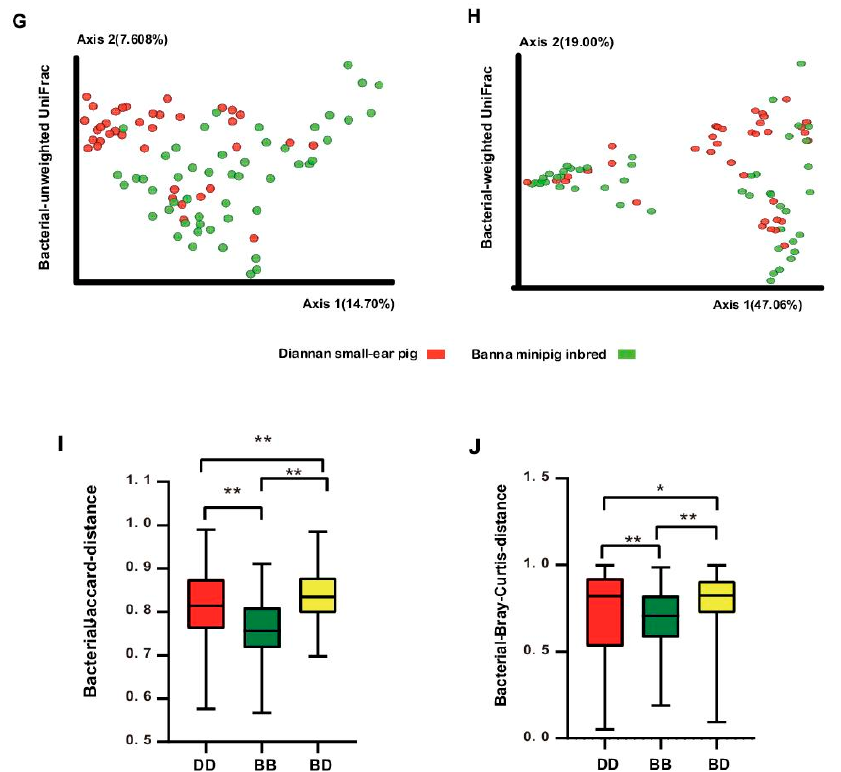
Figure 3. Comparison of alpha and beta diversity of the gut microbiota of Diannan small-ear pig and Banna minipig inbred. Four metrics were used for comparison including the number of observed OTUs ( A ), Shannon index ( B ), evenness index ( C ), and Faith index ( D ) in Diannan small-ear pig and Banna minipig inbred. Red and green bars represent the Diannan small-ear pig and Banna minipig inbred, respectively. ** p < 0.01, Mann–Whitney U-test. Jackknifed beta diversity analysis (Figure 3E–J) of gut microbiota for Diannan small-ear pig and Banna minipig inbred. ( E ): PCoA of bacterial Bray–Curtis. ( F ): PCoA of bacterial Jaccard. ( G ): PCoA of bacterial unweighted UniFrac. ( H ): PCoA of bacterial weighted UniFrac. ANOSIM, p < 0.01, Red squares and green circles respectively represented Diannan small-ear pig and Banna minipig inbred bacterial communities. Figure 3I,J shows the between-group and within-group distance based on Jaccard ( I ) and Bray–Curtis ( J ). DD: Distance within group of Diannan small-ear pig, BB: Distance within group of Banna minipig inbred, BD: The distance between the Diannan small-ear pig and the Banna minipig inbred. * p < 0.05, ** p < 0.01, Mann–Whitney